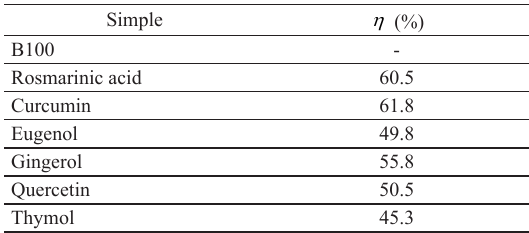
Table 6. Corrosion inhibition efficiency ( η ) of these additives on carbon steel in B100 in the absence and presence of 1000 ppm of different additives.